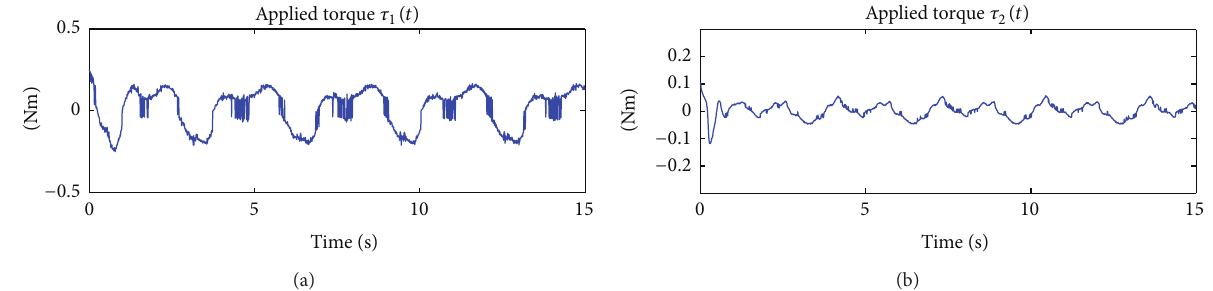
Figure 3: Applied torque by using the PD + Δ sign ( r ) scheme which does not consider any adaptation.